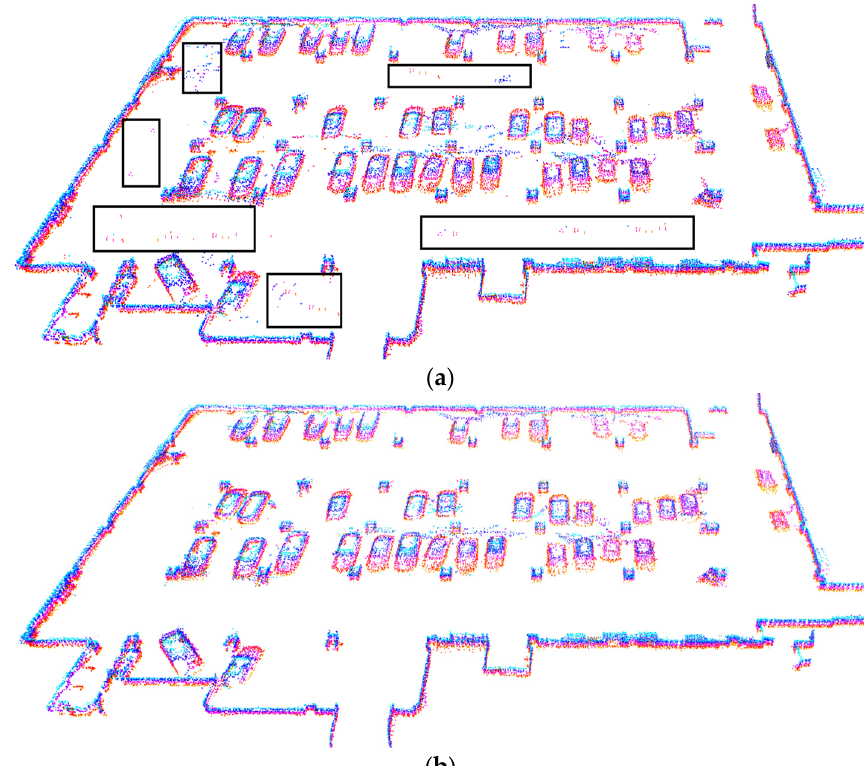
Figure 13. The 3D octo-map: ( a ) the original map without SOR filter, with outliers due to noise or dynamic interference shown in the black box; and ( b ) the map with SOR filter, as can be seen the outliers in the black box, are almost completely filtered